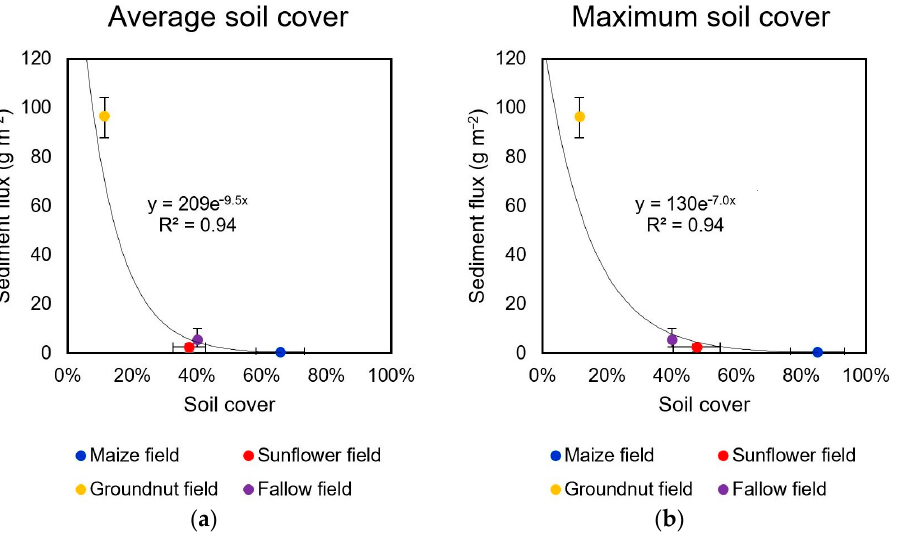
Figure 9. Relation between average sediment flux and soil cover. ( a ) Relations with average soil cover and ( b ) maximum soil cover from planting rows. The error bars indicate the variance for soil cover due to shadows in the UAV images, and the minimum and maximum value of the sediment flux.